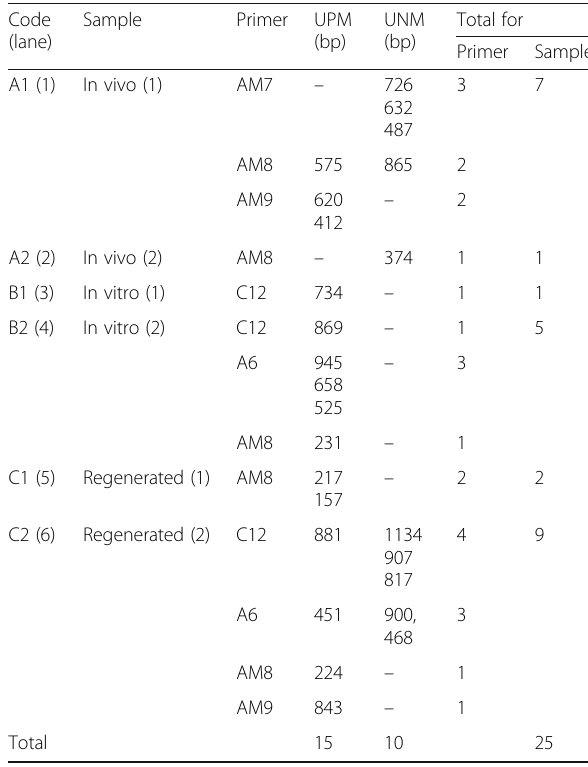
Table 4 Unique markers based on RAPD for different samples of J. curcas